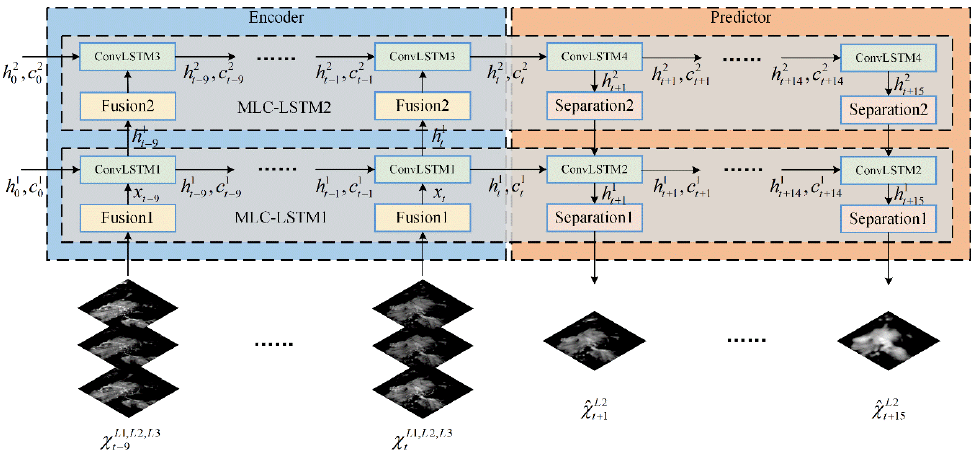
Figure 3. The schematic of the encoder – predictor architecture.